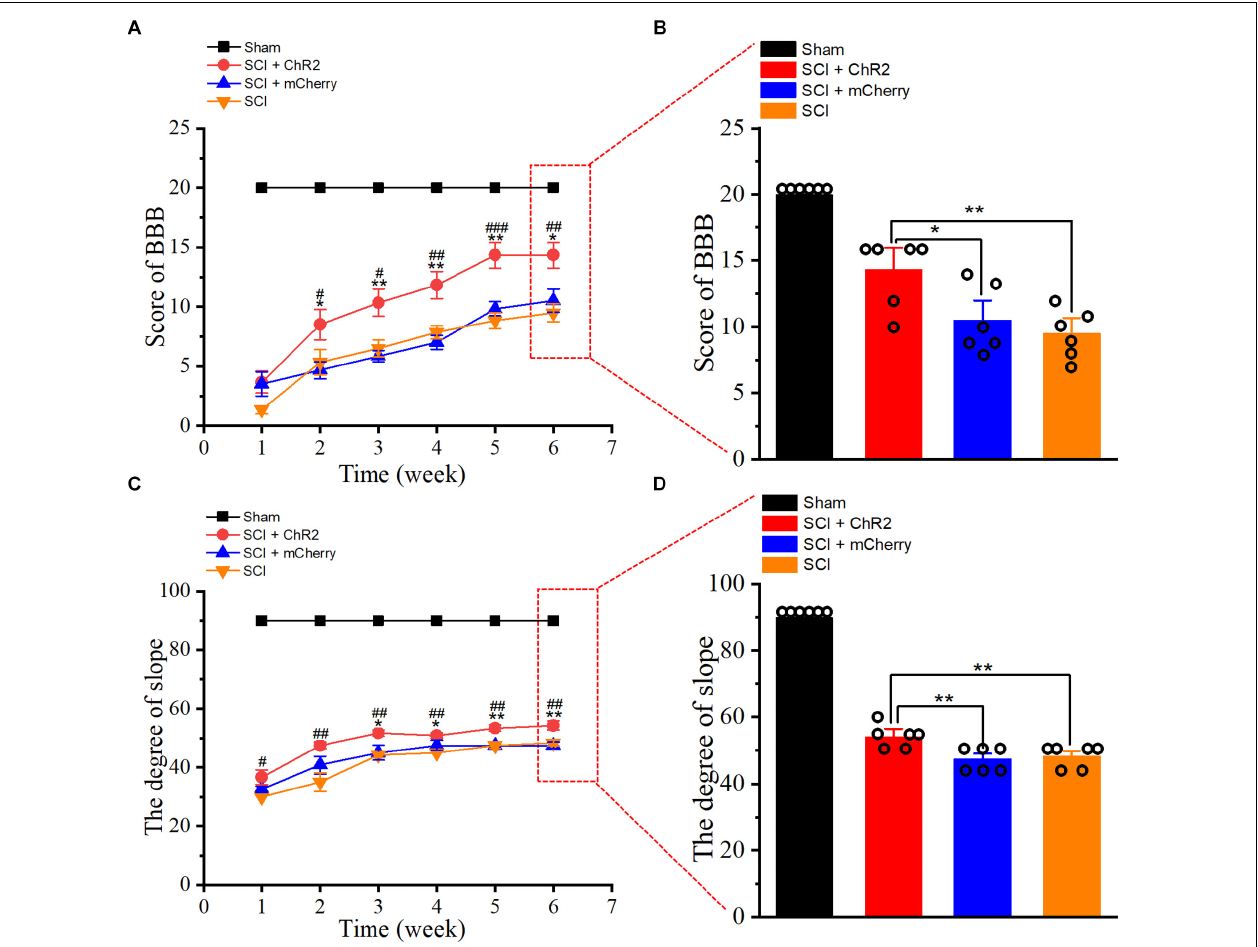
FIGURE 3 | Accurate stimulation of M1 glutamatergic neurons promotes functional recovery after SCI in rats. (A) The line chart of BBB score of rats at 1–6 weeks after SCI. (B) The histogram of BBB score of rats at 6 weeks after SCI. (C) The line diagram of ramp stability angle of rats 1–6 weeks after SCI. (D) The ramp stability angle diagram of rats 6 weeks after SCI. [in chart A, C : * indicates P < 0.05 between SCI + ChR2 group and SCI + mCherry group, **indicates P < 0.01, # indicates P < 0.05 between SCI + ChR2 group and SCI group, ## indicates P < 0.01, ### indicates P < 0.001; in chart B, D histograms: * indicates P < 0.05, **indicates P < 0.01, n = 6 rat/group, using one-way ANOVA. Data are shown as means (bar graphs) and standard error of the mean (error bars), with individual data points indicated as